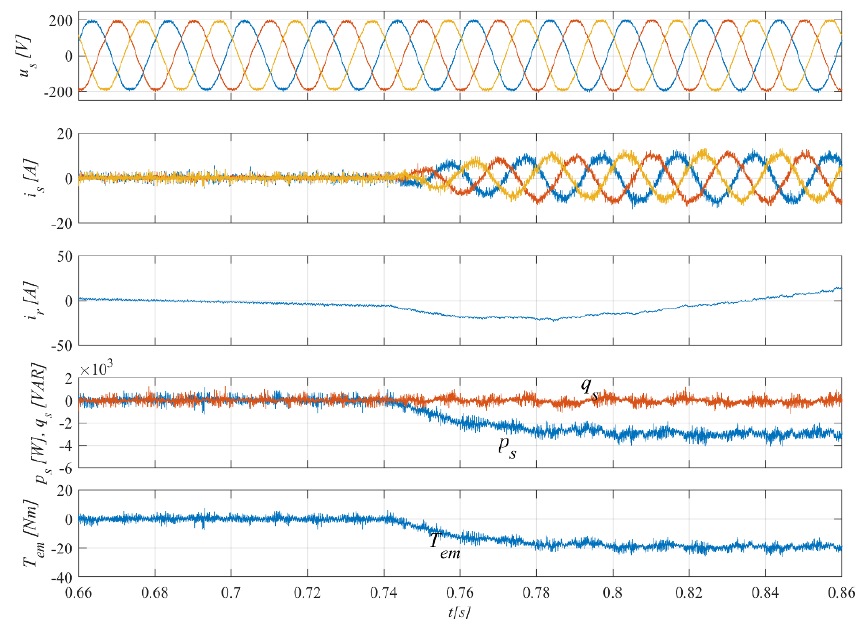
Figure 16. Experimental tests results of DPC in case of symmetrical grid voltage operation without the feedforward, decoupling mechanism and without information about the rotor current value included in the control. Q sref = 0, T emref = − 19.5 Nm.